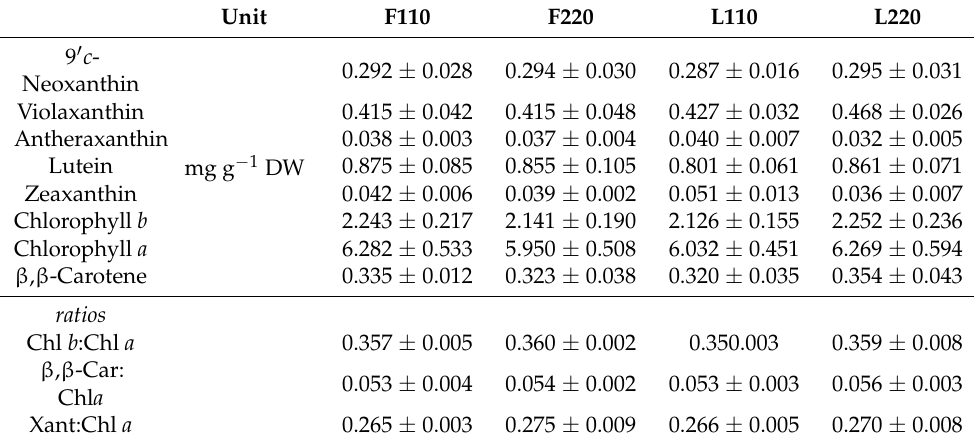
Table 3. Photosynthetic pigments concentrations (mean ± sd) in H. portulacoides leaves ( n = 5). DW—dry